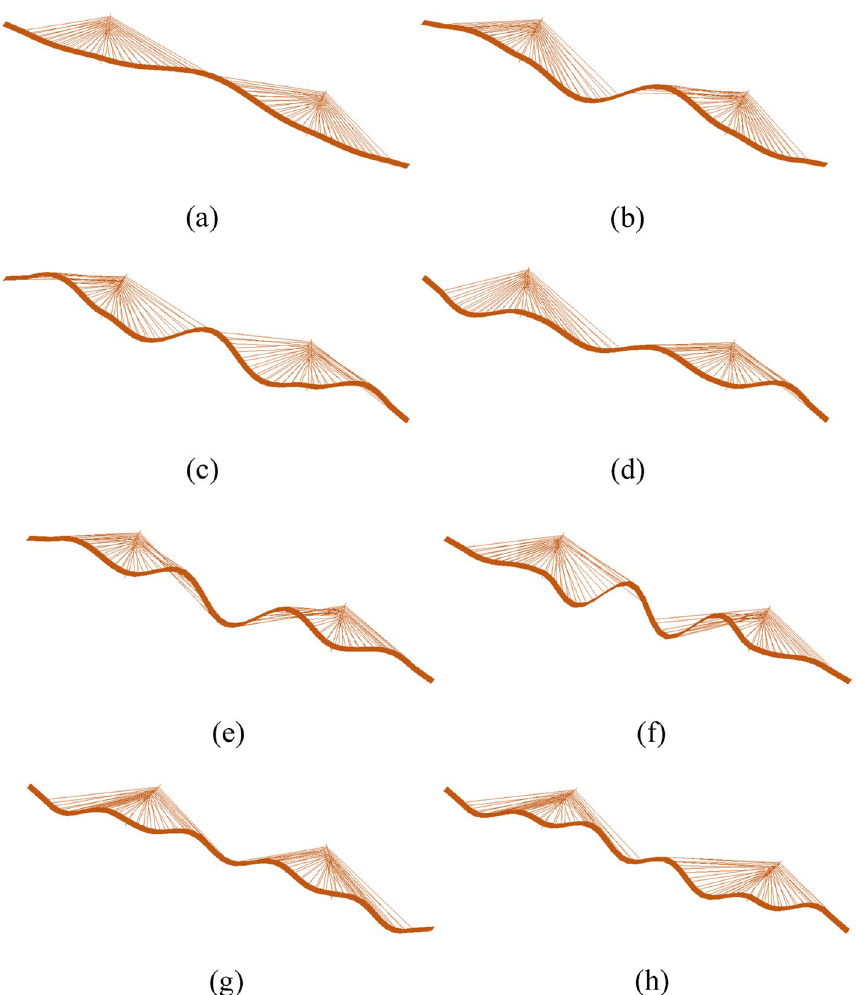
Fig. 8 Finite element modal analysis results of the Bridge: ( a ) The 1st mode; ( b ) The 2nd mode; ( c ) The 3rd mode; ( d ) The 4th mode; ( e ) The 5th mode; ( f ) The 6th mode; ( g ) The 7th mode; (h) The 8th